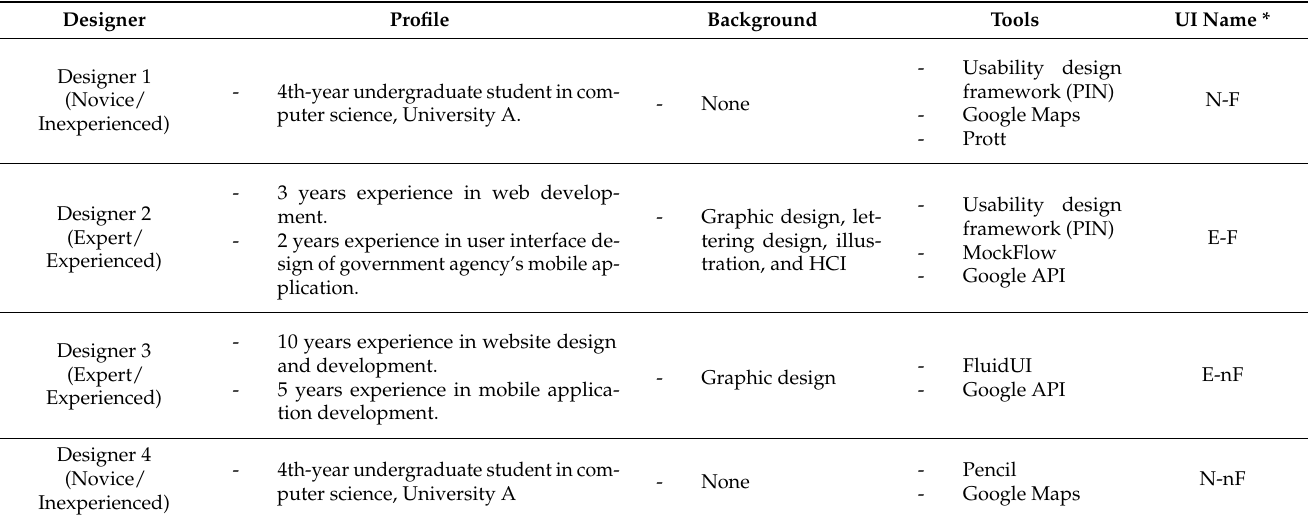
Table 9. The designers’ profiles.